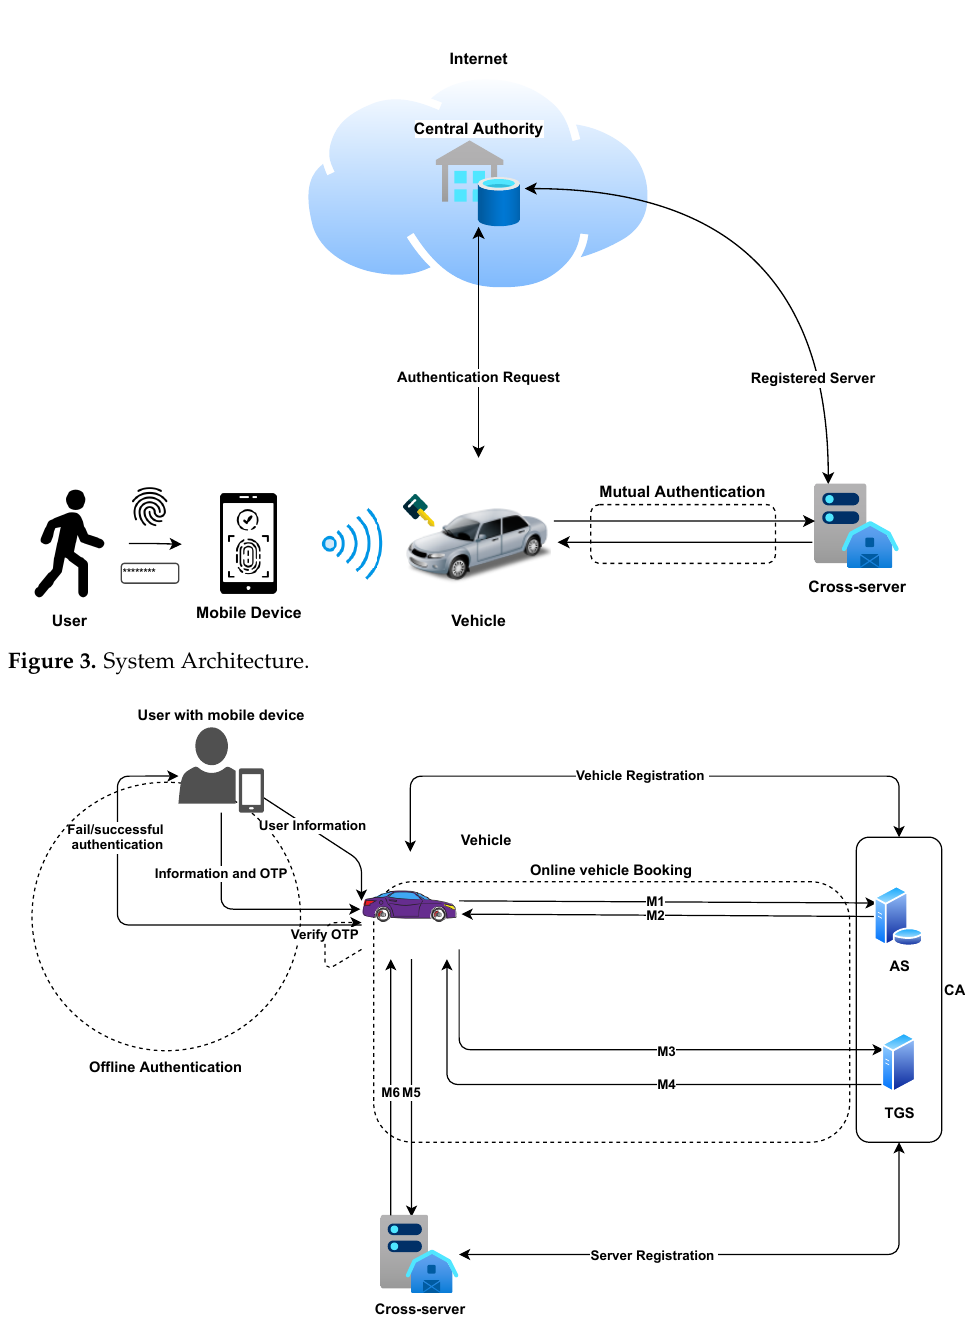
Figure 4. Network diagram of the proposed